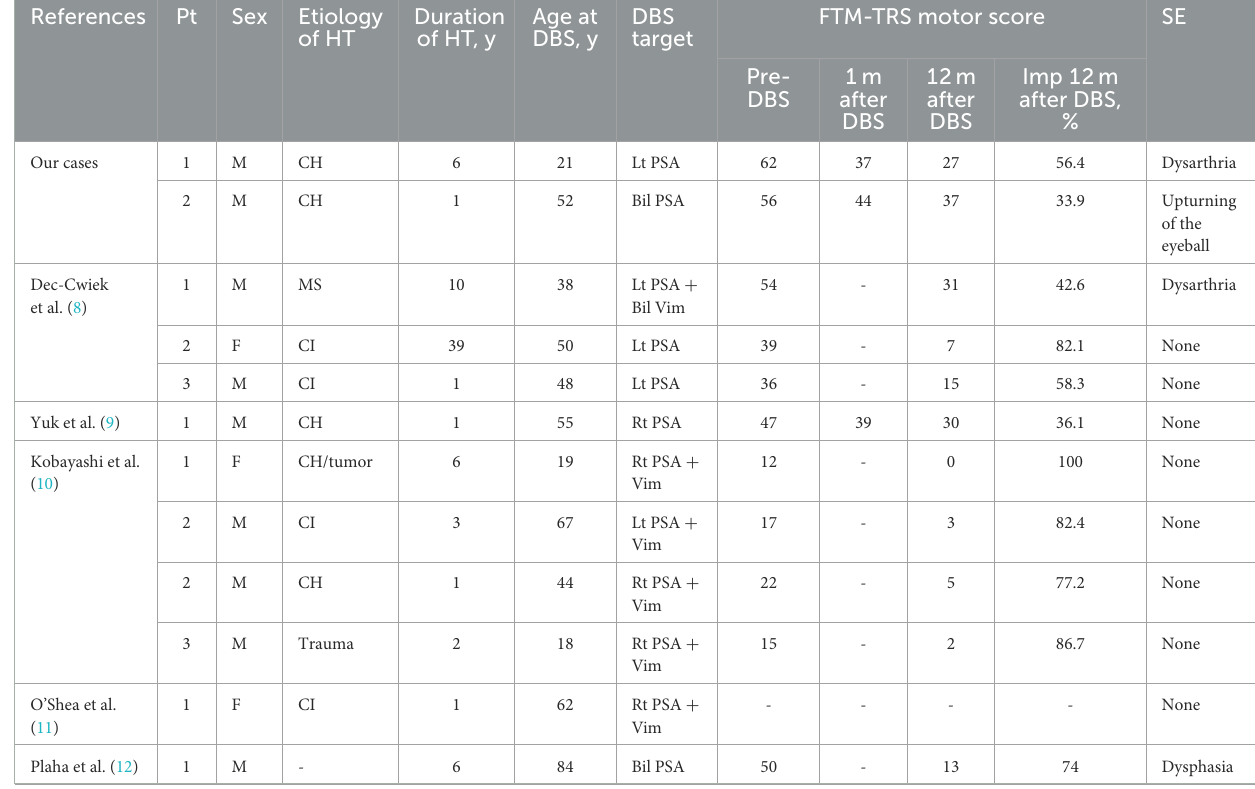
TABLE 1 Clinical outcomes of PSA-DBS for